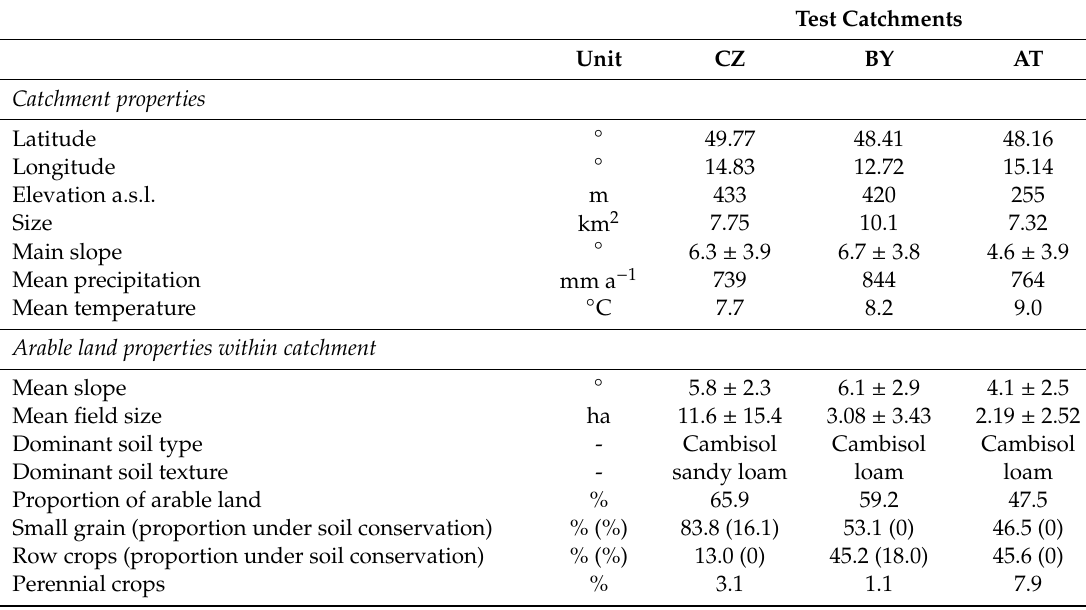
Table 1. Test catchment characteristics including land